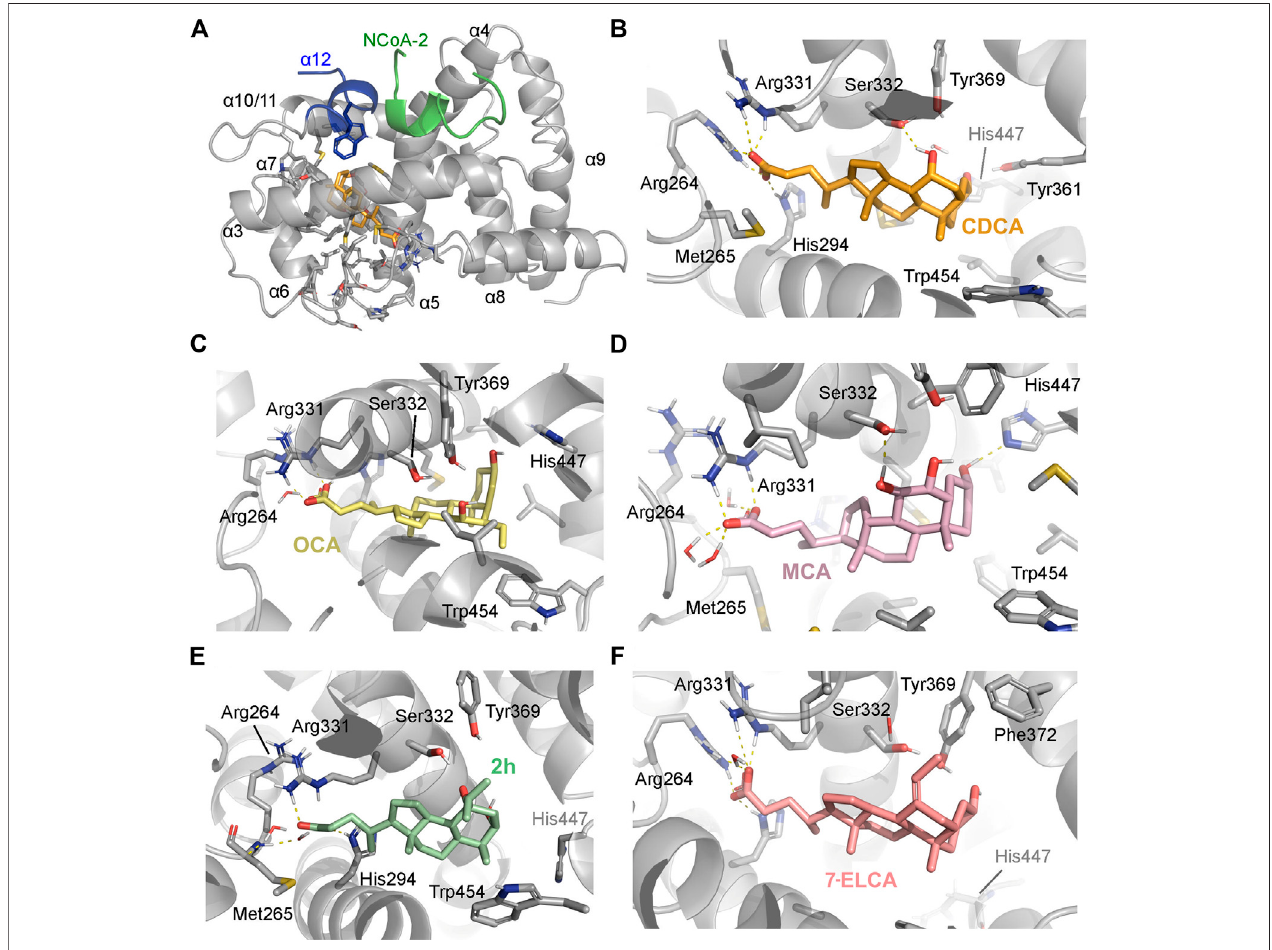
FIGURE 4 | (A) Ligand binding domain of human FXR, bound to the co-activator peptide (NcoA-2/SRC-2, in green) on the AF-2 cavity, composed by the α -12. All helices mentioned in the text are numbered α 1 – 12. Representative snapshots from the molecular dynamics simulation (500 ns per system), highlighting the residues involvedininteractions: (B) CDCA(PDBID:6HL1), (C) OCA, (D) muricholicacid(MCA), (E) 7 β -isopropyl-CDCA(2h)and (F) 7-ELCA(2a).Interactionsarerepresentedby dashedlines.FXRresiduesarecoloredaccordingtotheatomtypesoftheinteractingaminoacidresidues(protein ’ scarbon,lightgrey;nitrogen,blue;oxygen,red).